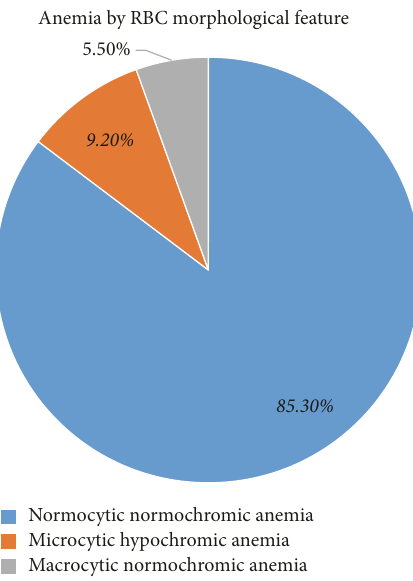
Figure 1: RBC morphological feature among anemic elderly study participants ( 𝑛 = 109